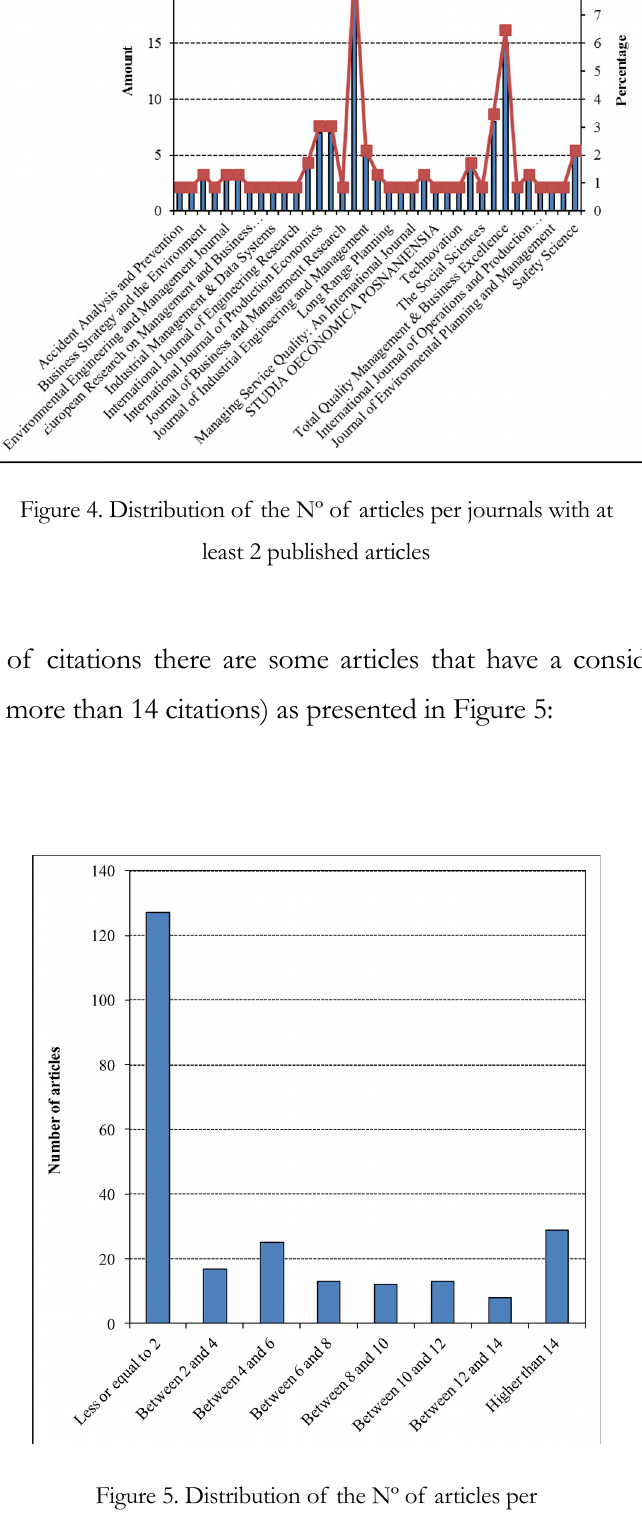
Figure 5. Distribution of the Nº of articles per number of